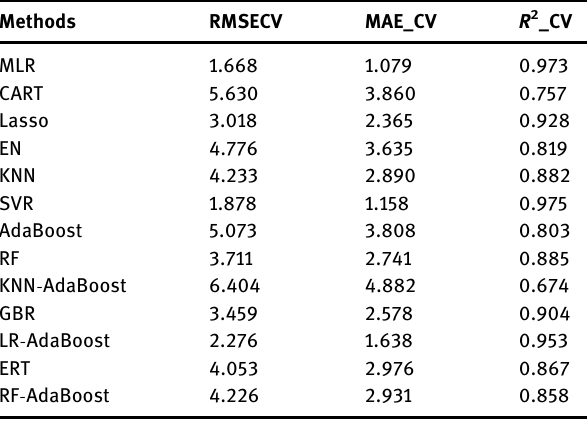
Table 4: The TFCV results of the thirteen methods Methods